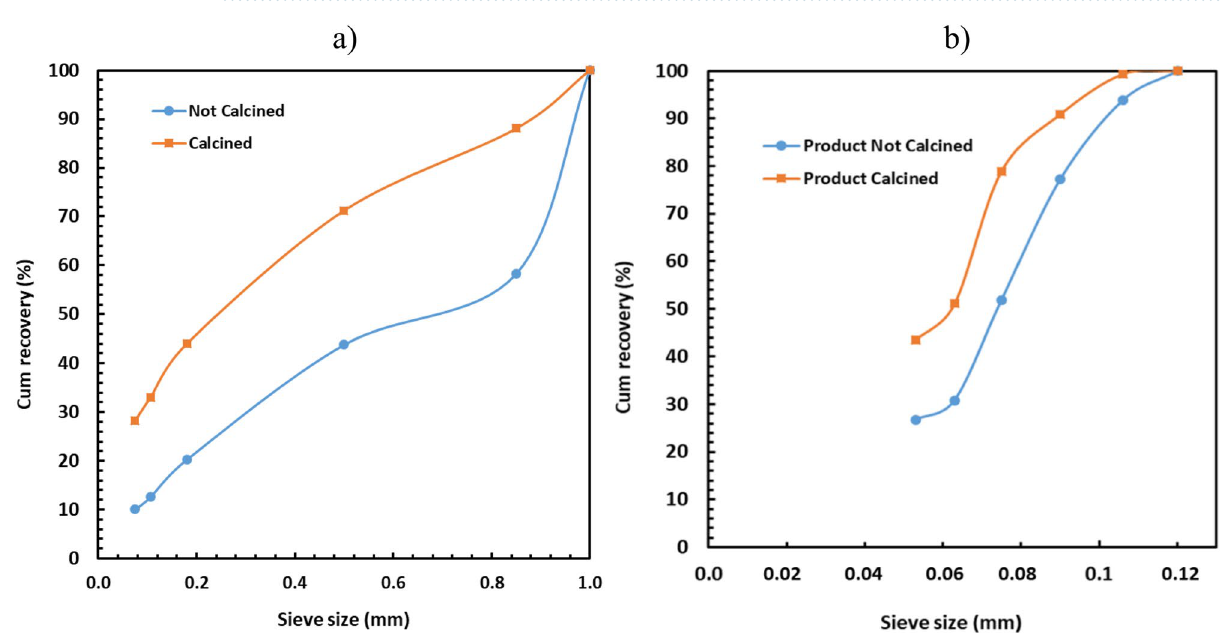
Figure 8. Influence of calcination on cumulative recovery of lithium in the case of ( a ) feed of BBMWI and ( b ) product of BBMWI in the case of